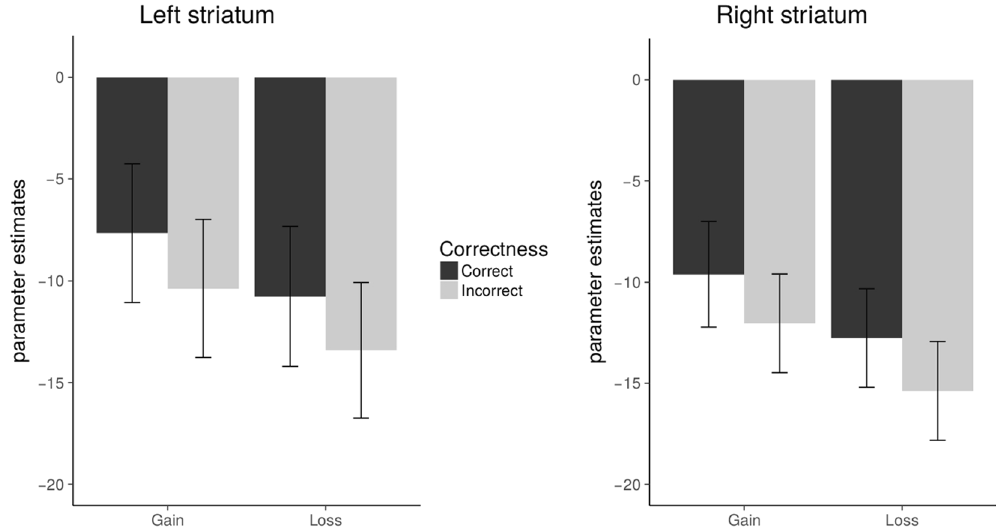
Figure 4. Parameter estimates of left and right anatomical striatal clusters (NAcc) for the contrasts Correct-Gain > Incorrect-Gain indicated by the label “Gain”, and Correct-Loss > Incorrect-Loss indicated by the label